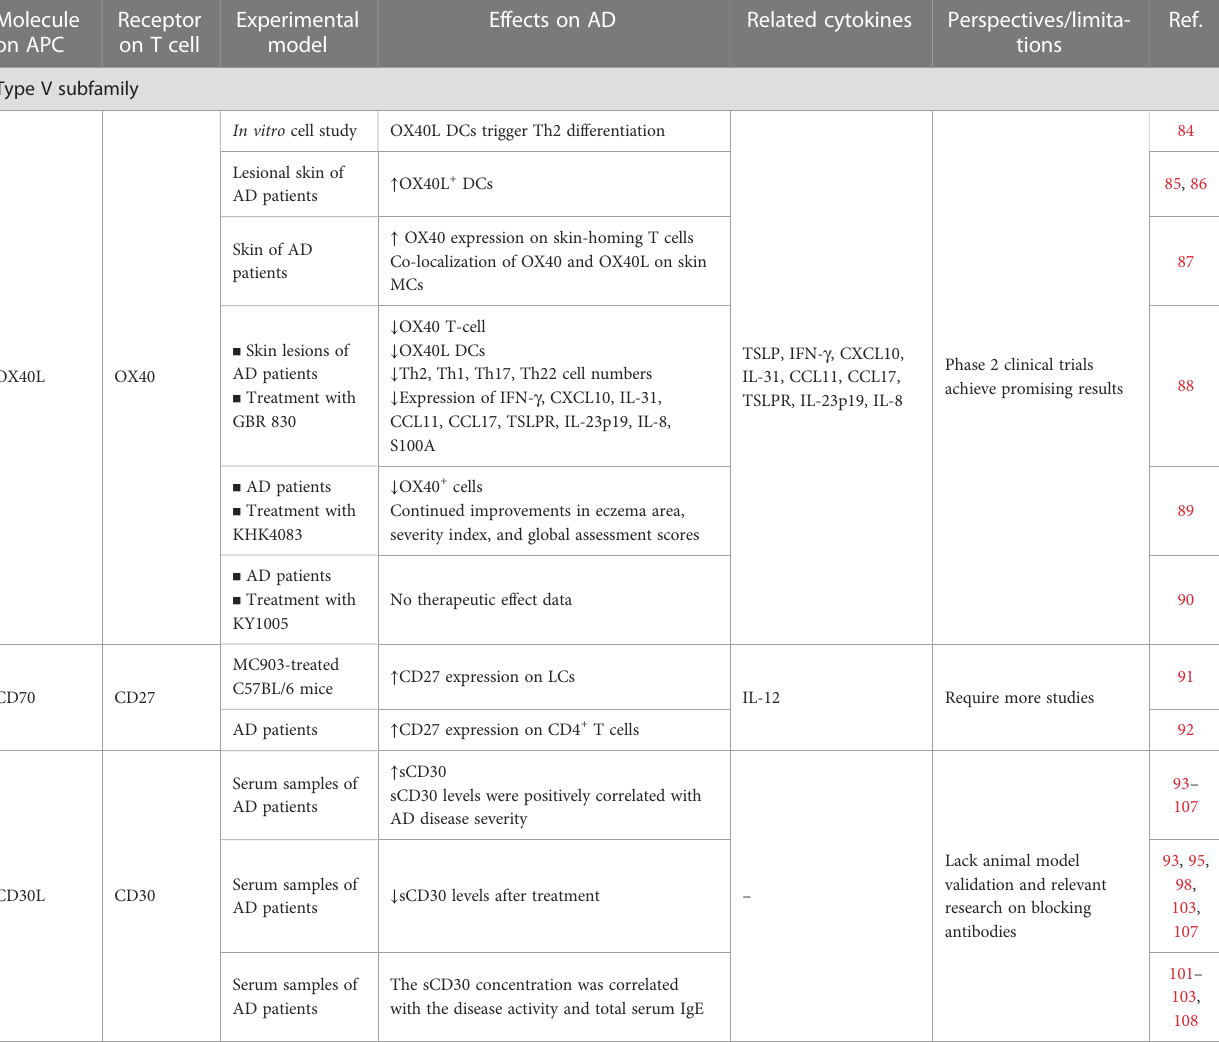
TABLE 2 Preclinical and clinical studies on T cell co-stimulatory and co-inhibitory molecules of the TNF and TNFR superfamilies. Molecule Receptor on APC on T cell